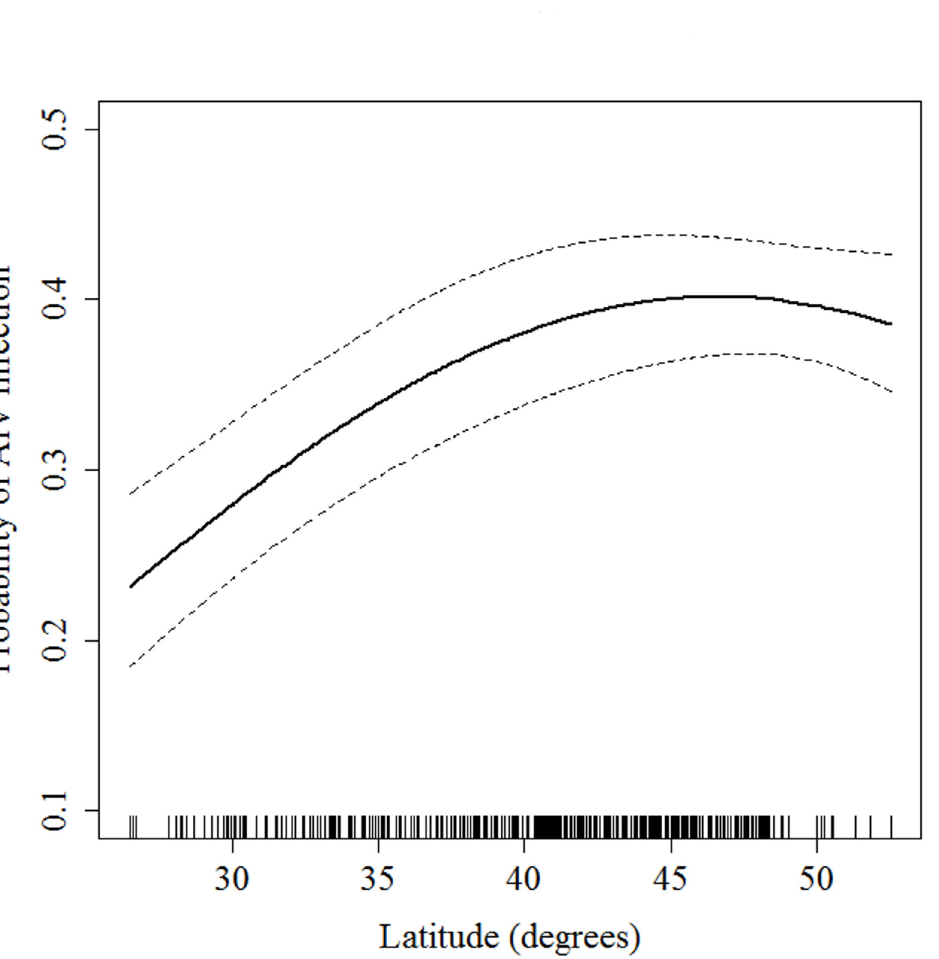
Fig 4. Probability of avian influenza virus infection in Blue-winged Teal as a function of latitude of sampling location. Predicted probability was calculated based on the best-supported model (Table 3) with Age, Sex, Flyway, Season and Year set at hatch year, male, central, July-August and 2010 categories, respectively. Error bars represent 95% confidence